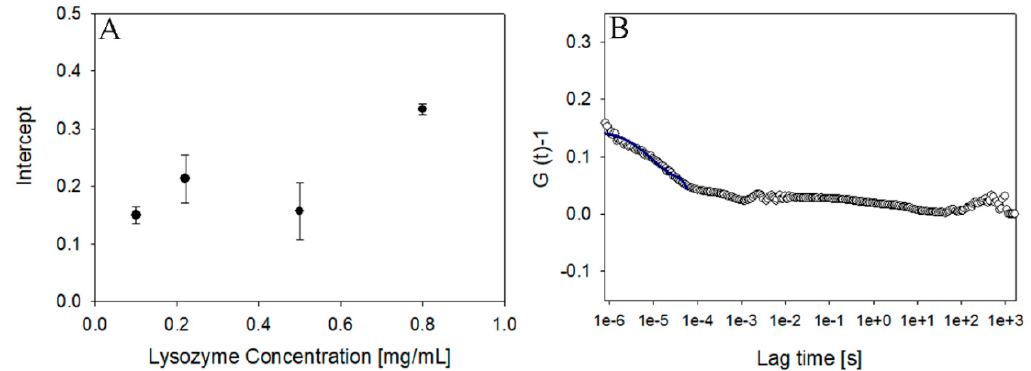
Figure 4. Intercept of lysozyme at different concentrations ( A ) and correlation function of lysozyme at lowest detectable concentration ( B ) (0.1 mg/mL, 100 mW laser intensity).